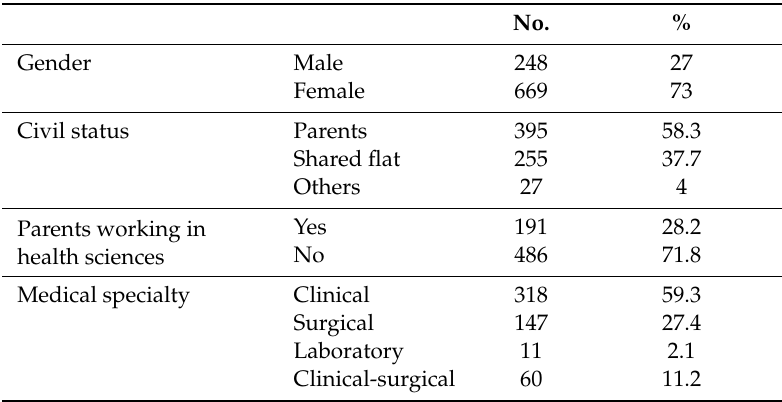
Table 1. Sociodemographic characteristics of the